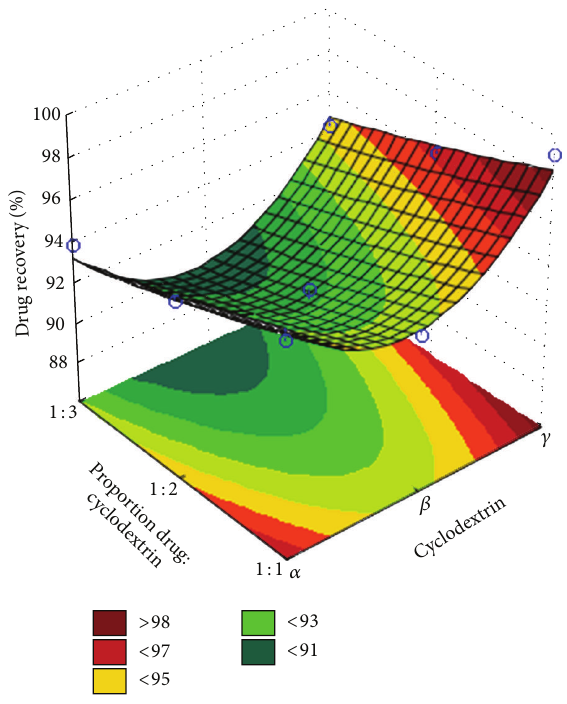
Figure 6: The resulting surface-response graph of the statistical analysis of the impact of the drug-CD ratio and the type of CD on recovery of LORA after photostability